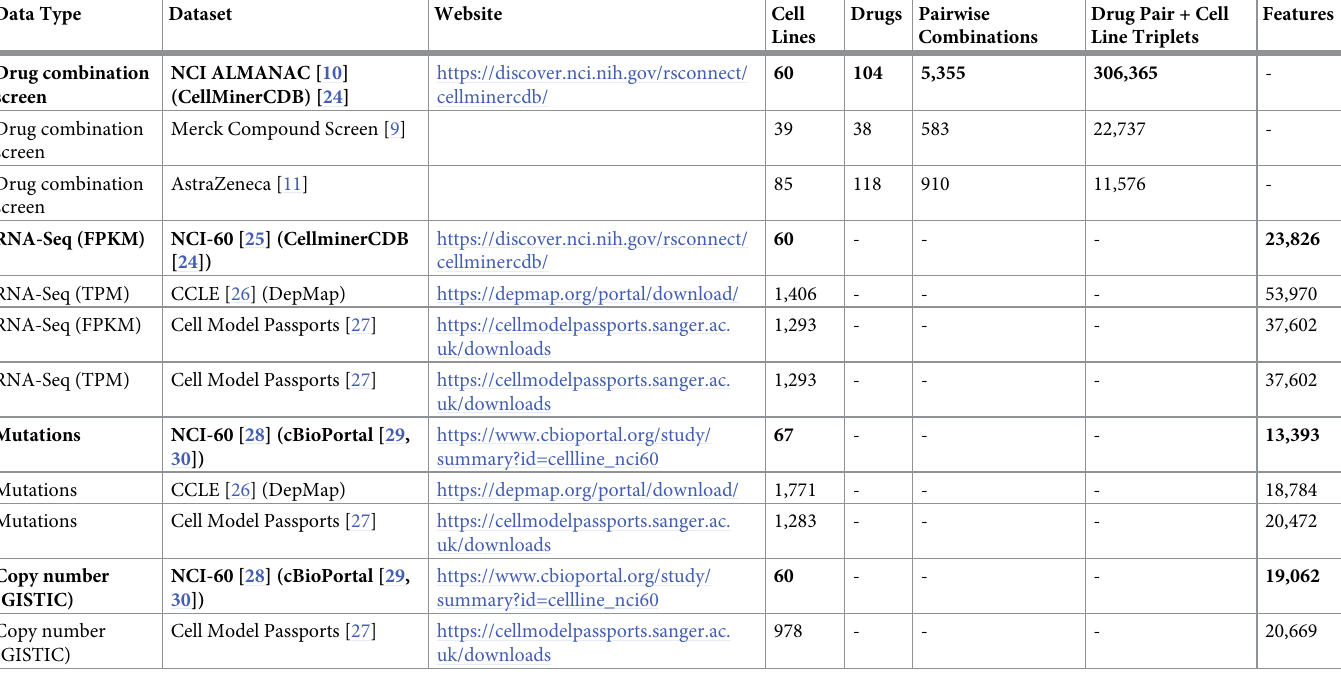
Table 1. Publicly available high-throughput drug combination screening datasets and large-scale cancer cell line genomics and transcriptomics datasets that can be used to develop drug synergy prediction models. The datasets that were used in this work are highlighted in